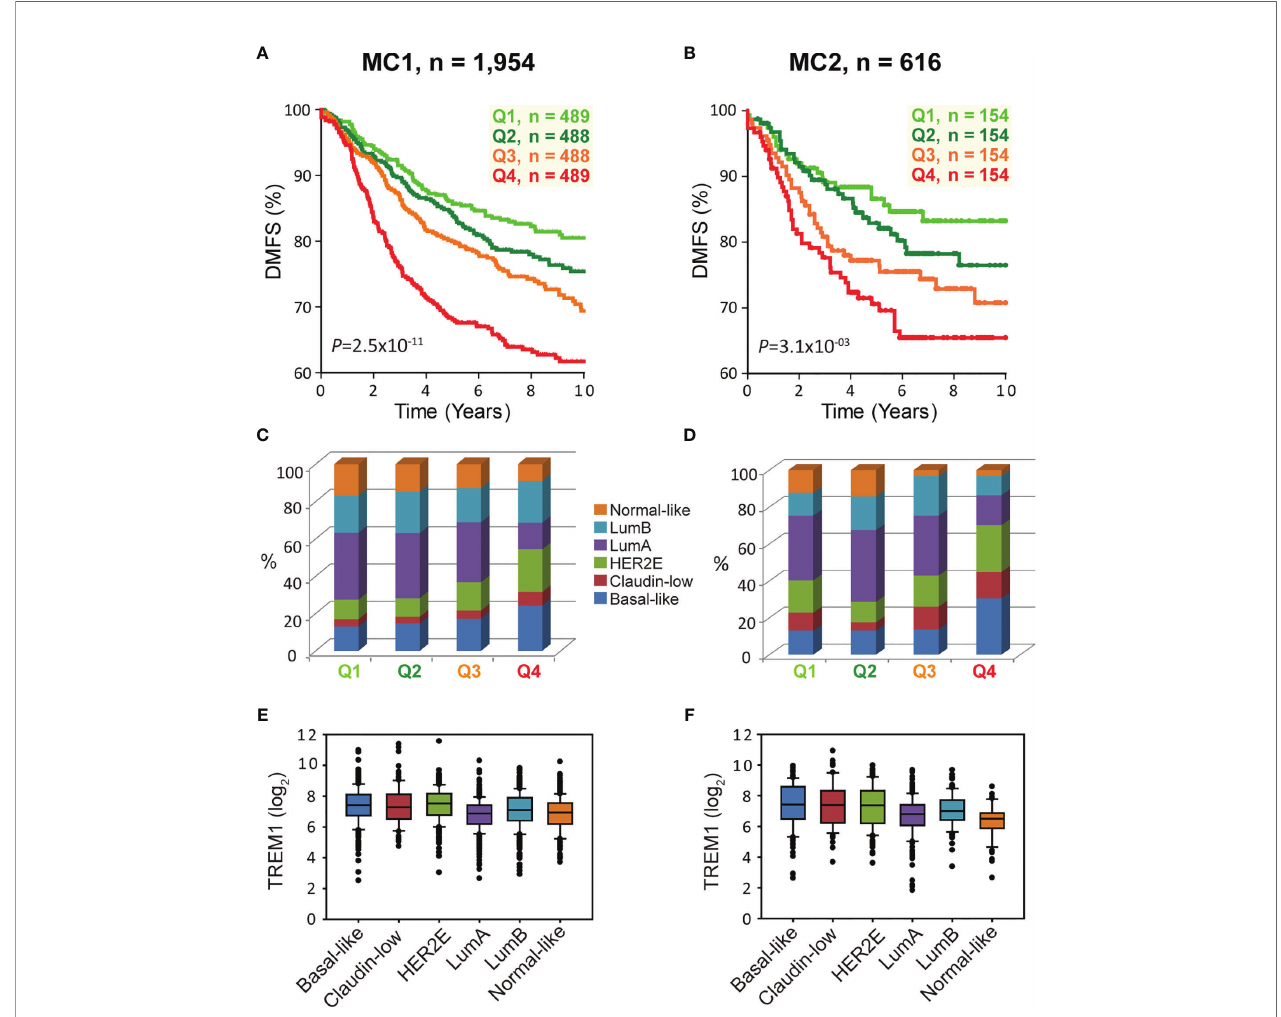
FIGURE 2 | High TREM1 is associated with greater risk of distant metastasis in two independent meta-cohorts. (A, B) Kaplan-Meier survival analysis of patients according to TREM1 expression quartiles in (A) the MC1 cohort and (B) the MC2 cohort. Proportions of molecular subtypes within TREM1 quartiles are shown for (C) the MC1 cohort and (D) the MC2 cohort. Box plots of TREM1 expression distributions within molecular subtypes are shown for (E) the MC1 cohort and (F) the MC2